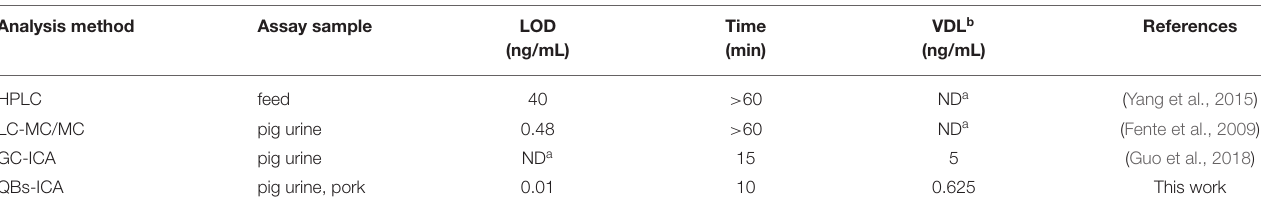
TABLE 2 | Comparison of different methods for the detection of